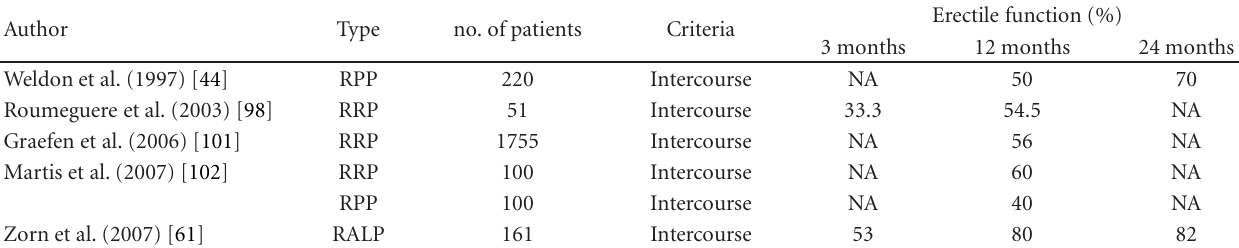
Table 5: Recovery of erectile function rates following RRP, RPP, and